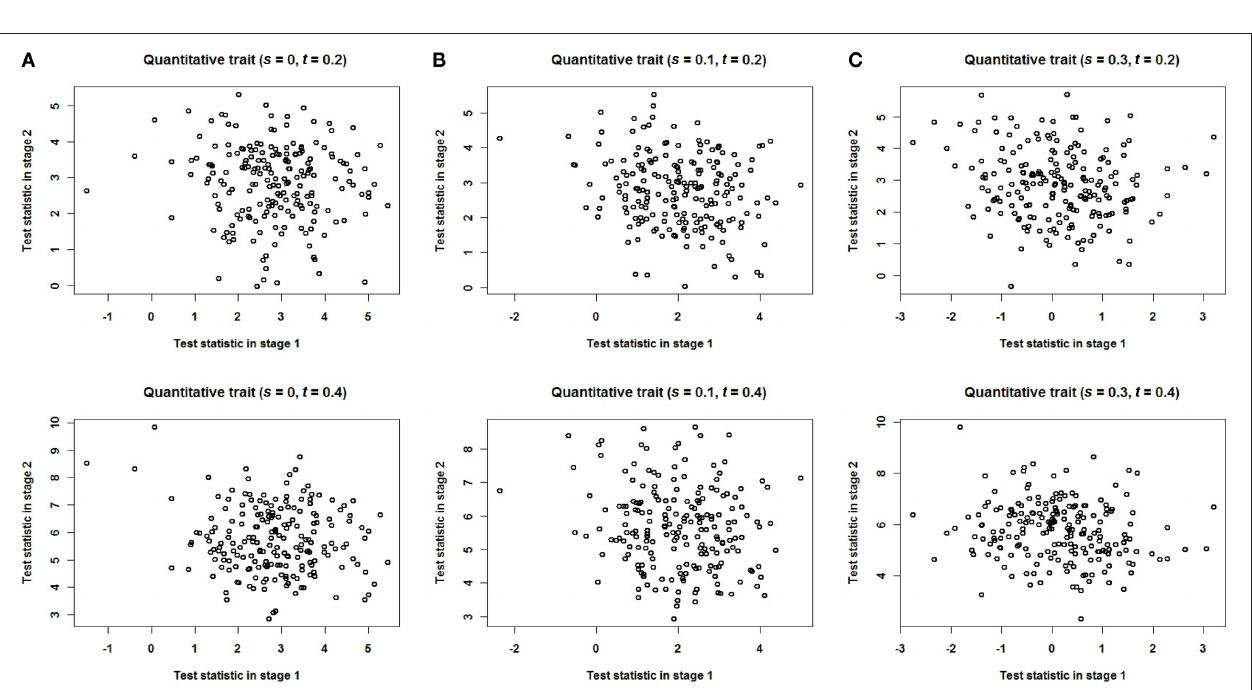
FiGure A1 | scatter plot of the test statistics in stage 2 versus the test statistics in stage 1 in the two-stage procedure under the null. (A) is for s = 0; (B) is for s = 0.1; (C) is for s = 0.3. t =